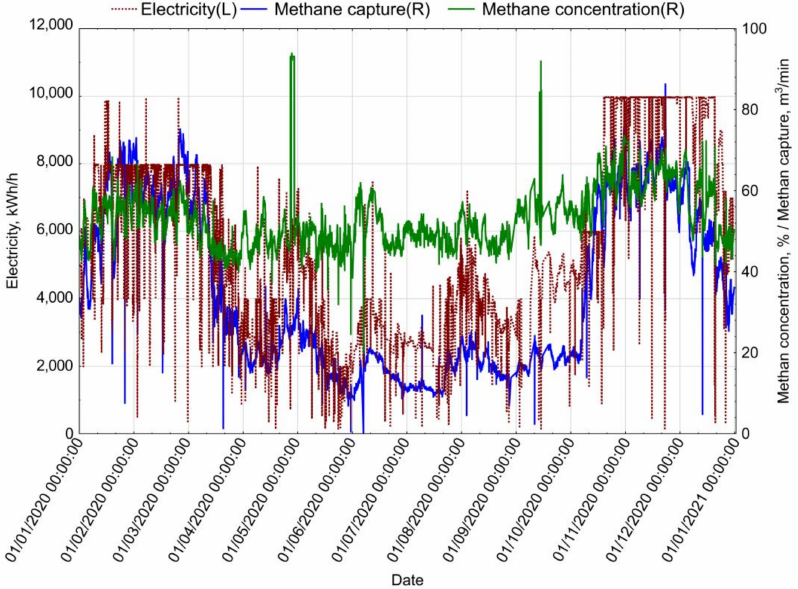
Figure 7. Variability of generated electricity, capture, and concentration of the methane in the analyzed